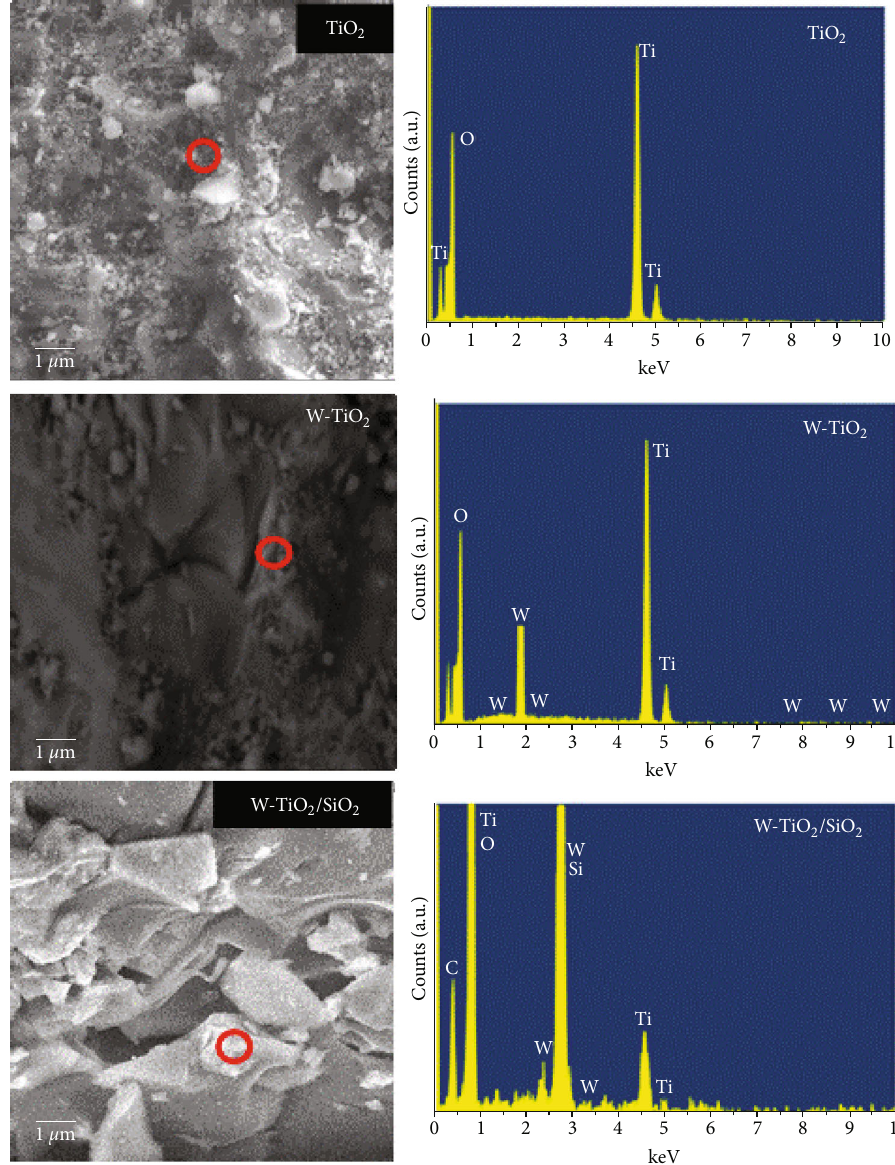
Figure 3: SEM micrographs and EDS pro fi les of selected areas on the TiO